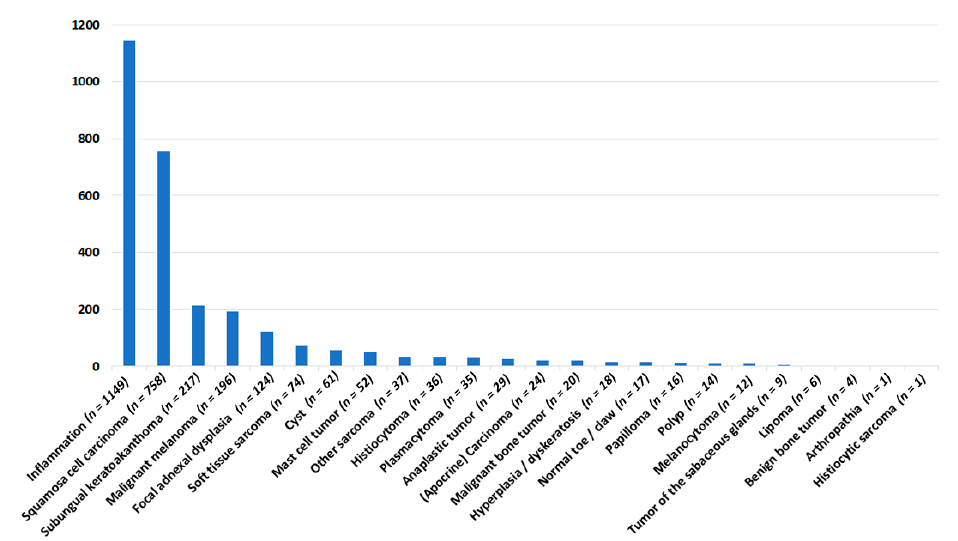
Figure 1. Histopathological main diagnoses in the digital samples of 2912 dogs submitted to Laboklin GmbH & Co. KG during the years 2014–2019 .